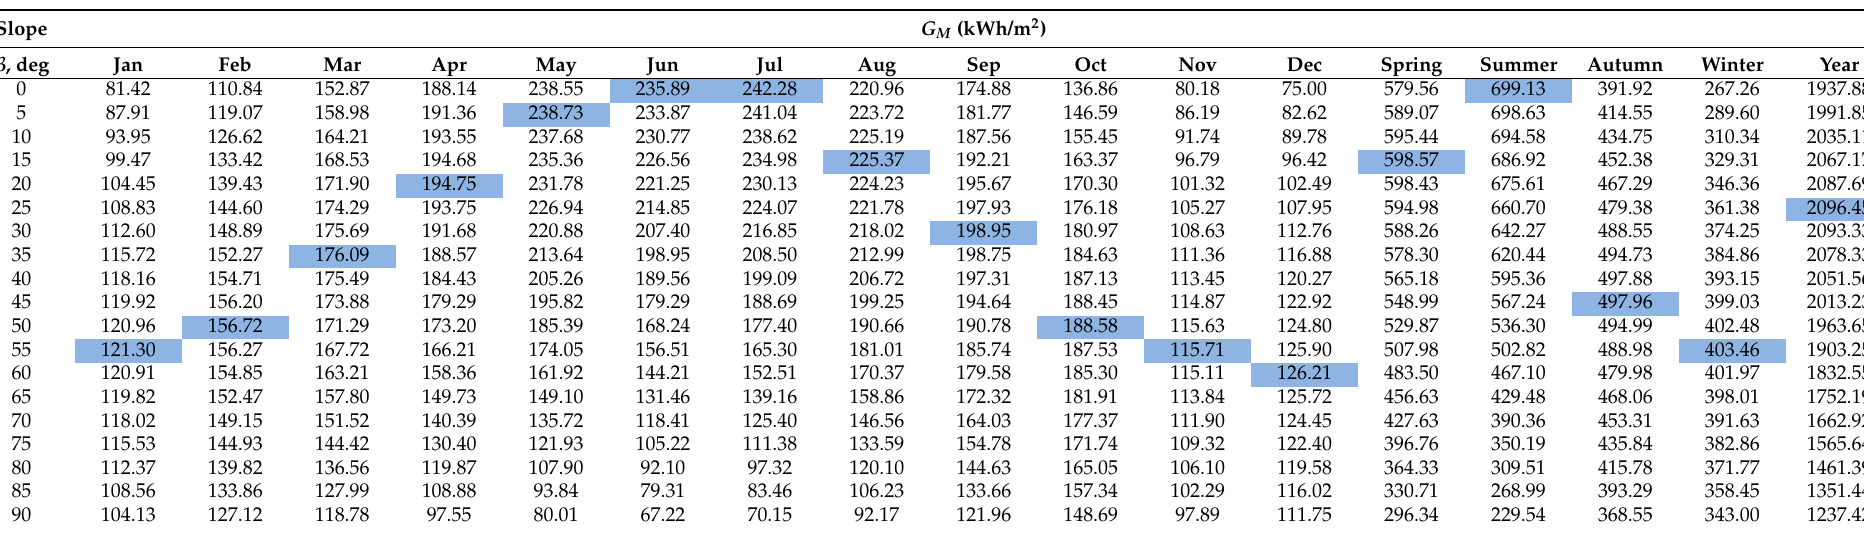
Table 15. Monthly total energy received by an inclined surface for each month of the year and for different slope angles ( β ) at Athalassa. The optimum slope angles for each month are highlighted.